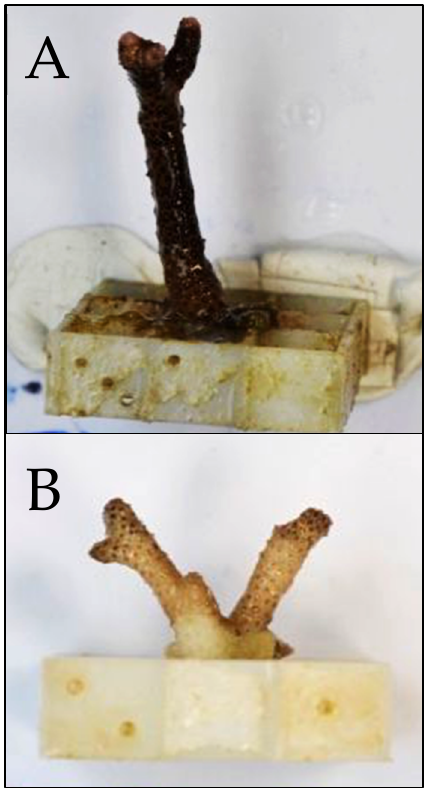
Figure 1. Representative images used in the estimation of relative photosymbiont abundance. Panel ( A ) depicts a healthy, unbleached coral from the control temperature, high pCO 2 treatment (color score = 5.69). Panel ( B ) depicts a partially bleached coral from the high temperature, high pCO 2 treatment (color score = 4.56).